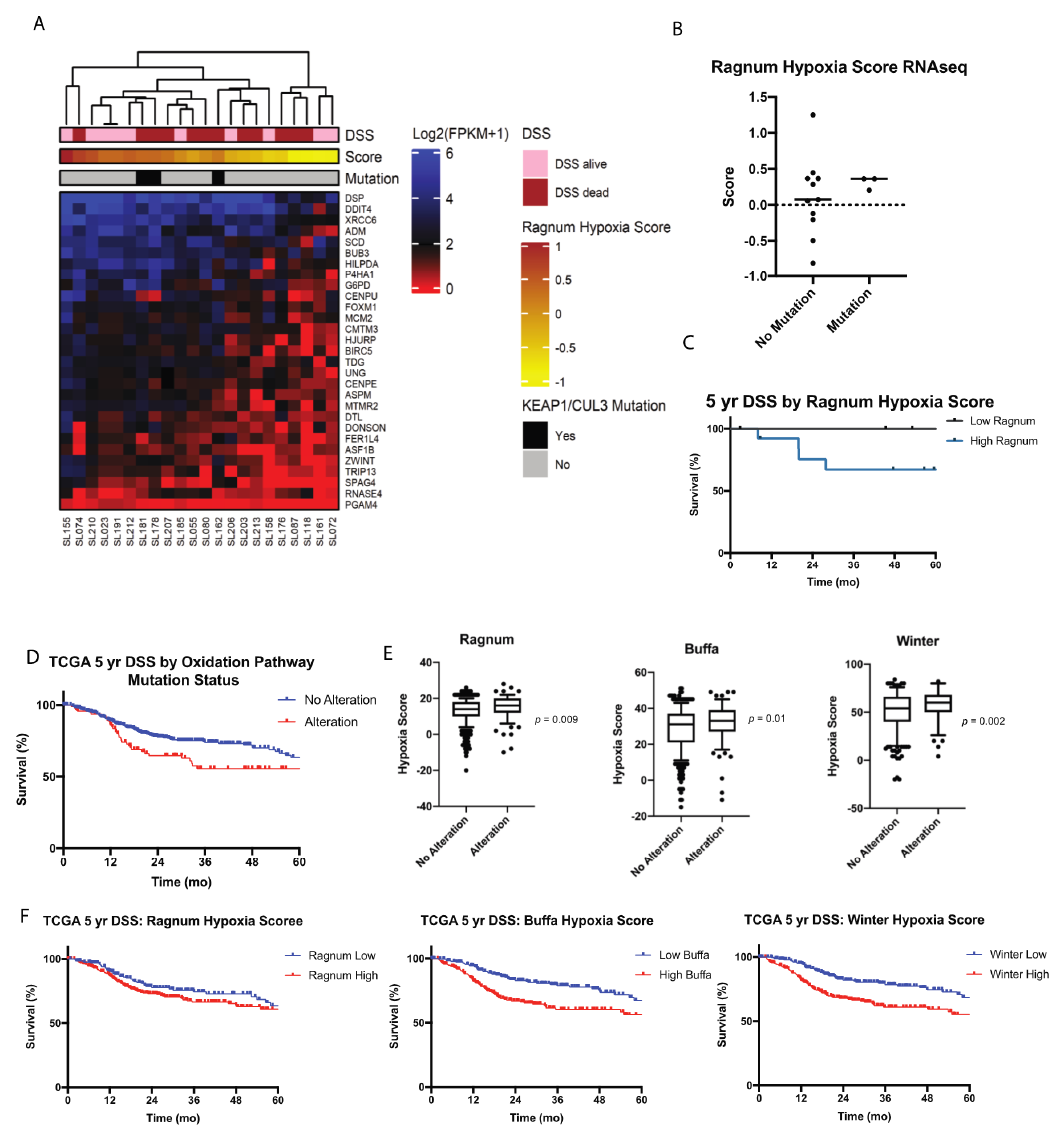
Figure 4. Oxidation pathway analysis in salvage larynx samples and primary TCGA samples. ( A ) Heat map depicting RNAseq data for 22 salvage laryngeal specimens clustered by DSS, Ragnum Hypoxia score, and KEAP1 mutation. ( B ) Ragnum hypoxia score stratified by the presence of absence of mutations in the Oxidation pathway. ( C ) Five-year disease specific survival by Ragnum hypoxia score. ( D ) Five-year DSS of TCGA samples stratifying by the presence of alterations in the Oxidation pathway. ( E ) Ragnum, Bu ff a, and Winter hypoxia scores stratifying by the presence of alterations in the Oxidation pathways, p -value < 0.05 considered significant as tested by Chi-squared. ( F ) Five-year DSS of TCGA samples stratifying by hypoxia